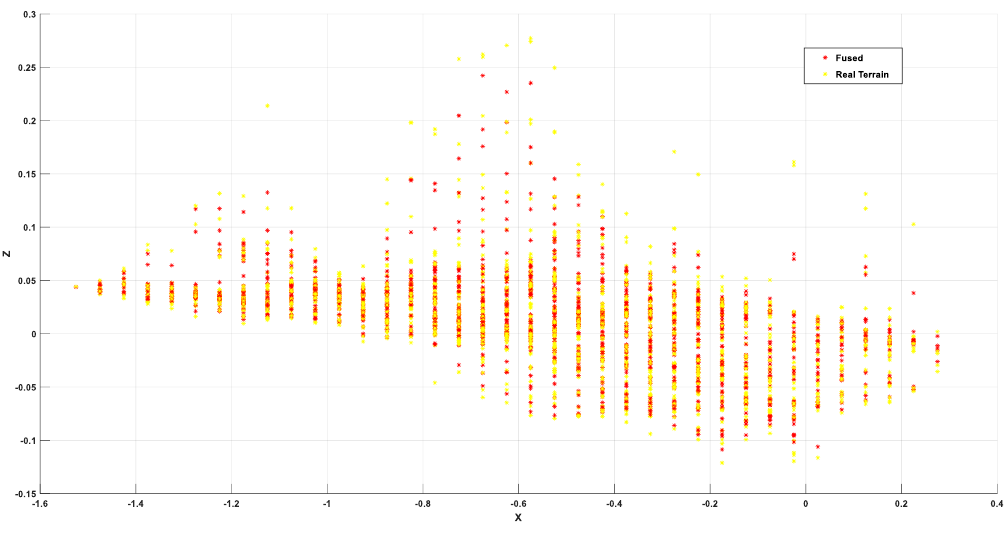
Figure 28. Point clouds results.